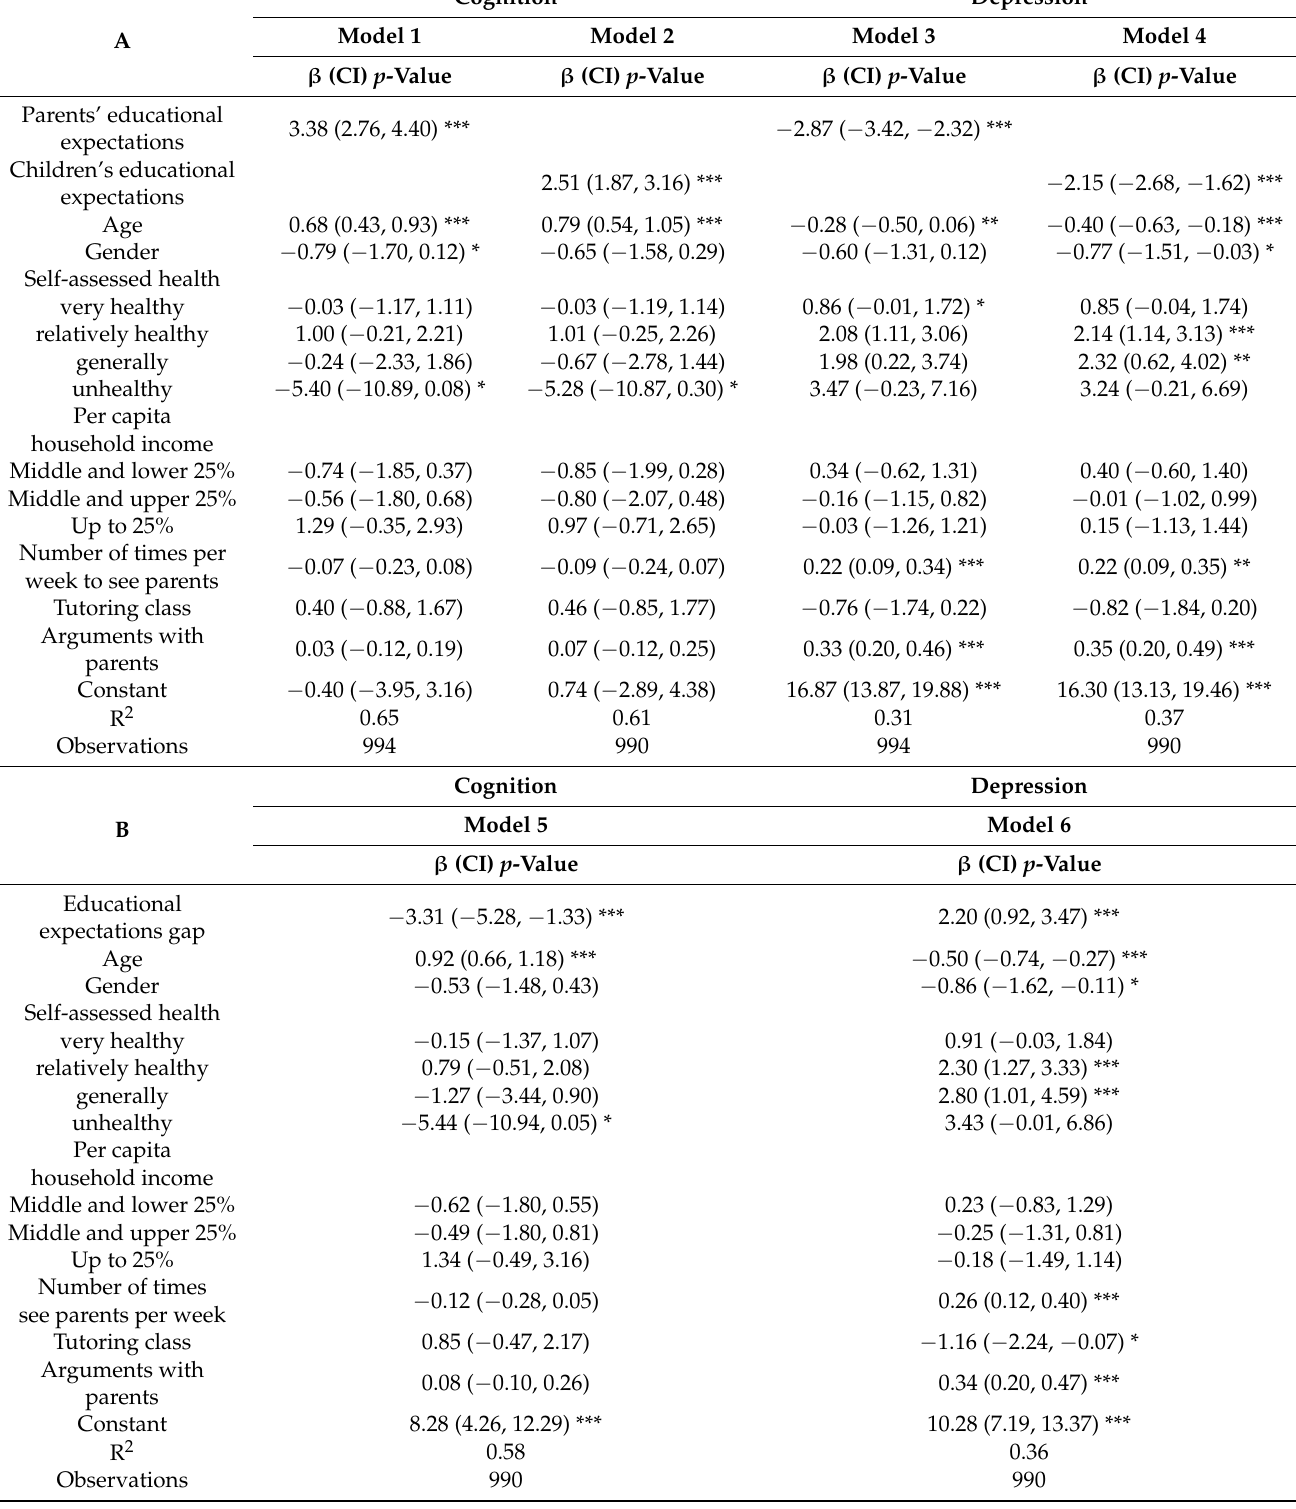
Table 2. ( A ) Benchmark regression results. ( B ) Benchmark regression